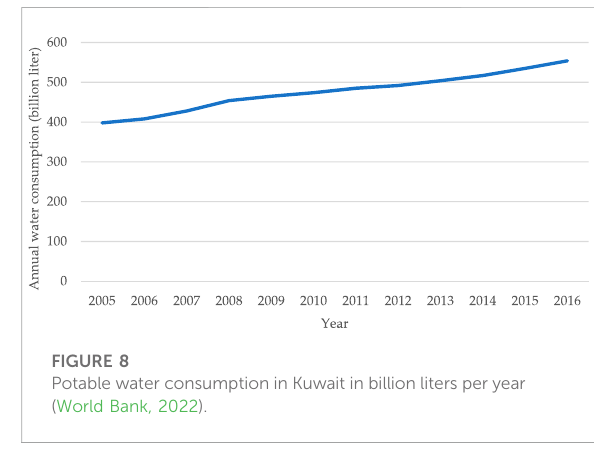
FIGURE 8 Potable water consumption in Kuwait in billion liters per year (World Bank,